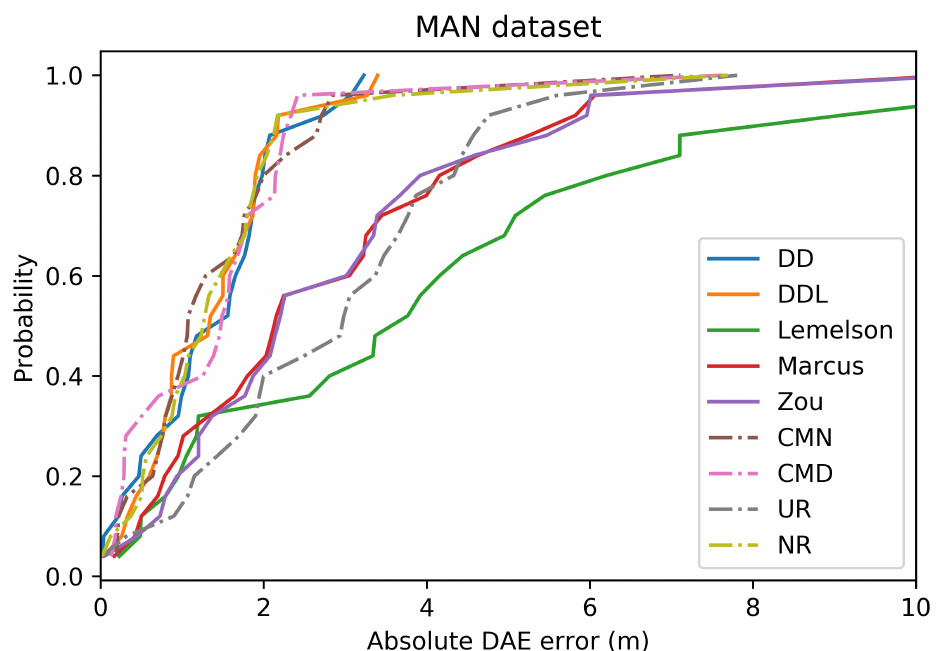
Figure 22. The Cumulative Distribution Function (CDF) of the absolute DAE error (in meters), for all the studied methods and baselines, in the validation set of the MAN